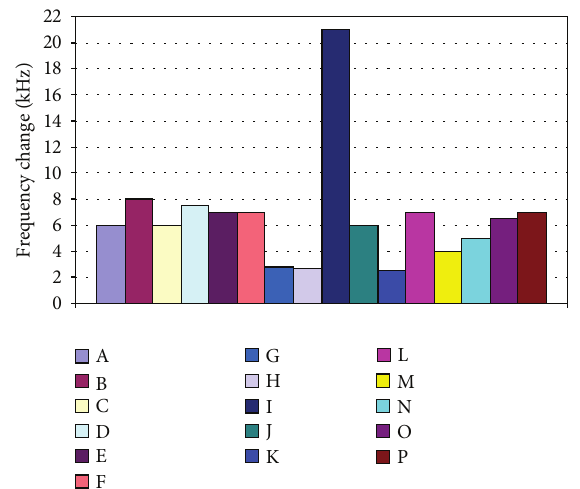
F 25: Frequency change for different stone samples, 1 plate capacitor.